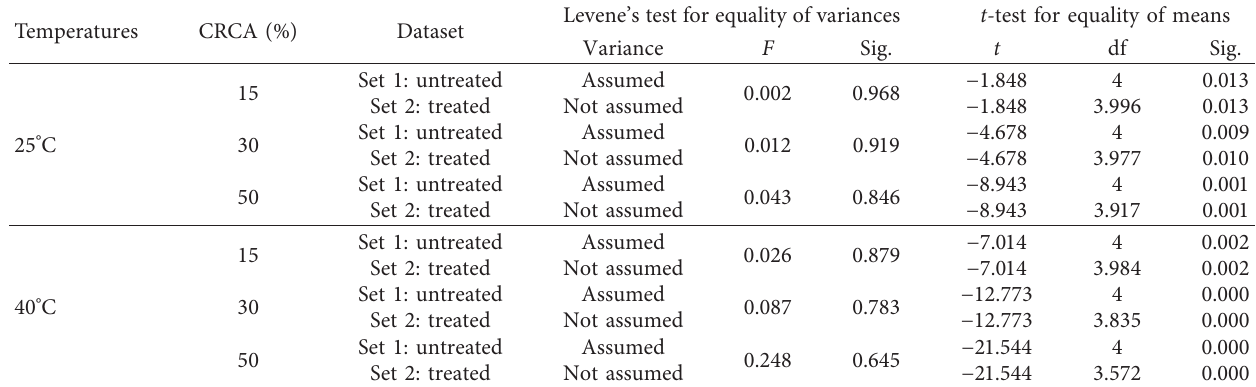
Table 7: Results of t -test to investigate the effect of CRCA percentage on the stiffness modulus.